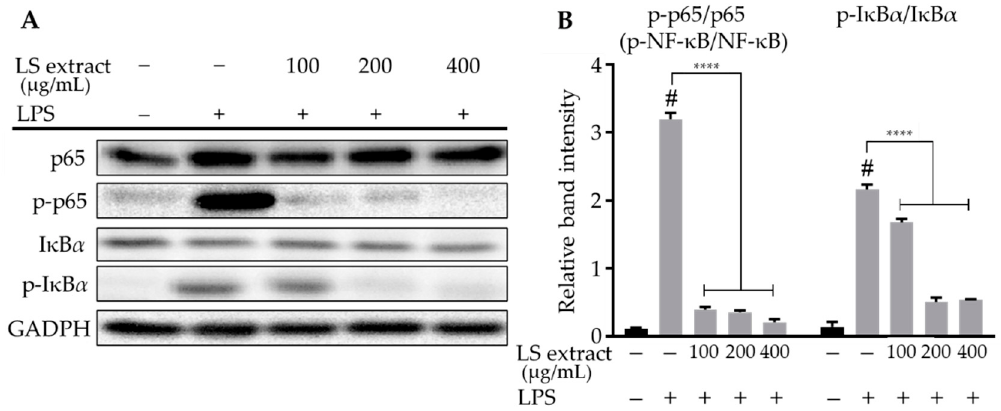
Figure 5. Effects of LS leaf extract on LPS-induced activation of the nuclear factor kappa B (NF- κ B) pathway in RAW 264.7 cells. Cells were pretreated with LS extract for 24 h, followed by LPS (1 μ g/mL) stimulation for 18 h. Whole-cell lysates were subjected to Western blotting ( A ). Glyceraldehyde 3-phosphate dehydrogenase (GAPDH) was used as a control. The relative band intensity of phosphorylated target protein to total target protein was analyzed using Image J ( B ) ( n = 3). Values represent the mean ± SD. Statistical significance was calculated by t -test and one-way ANOVA. # p < 0.05 vs. cells treated with media only; n. s., not significant; **** p < 0.0001 vs. cells treated with LPS only.